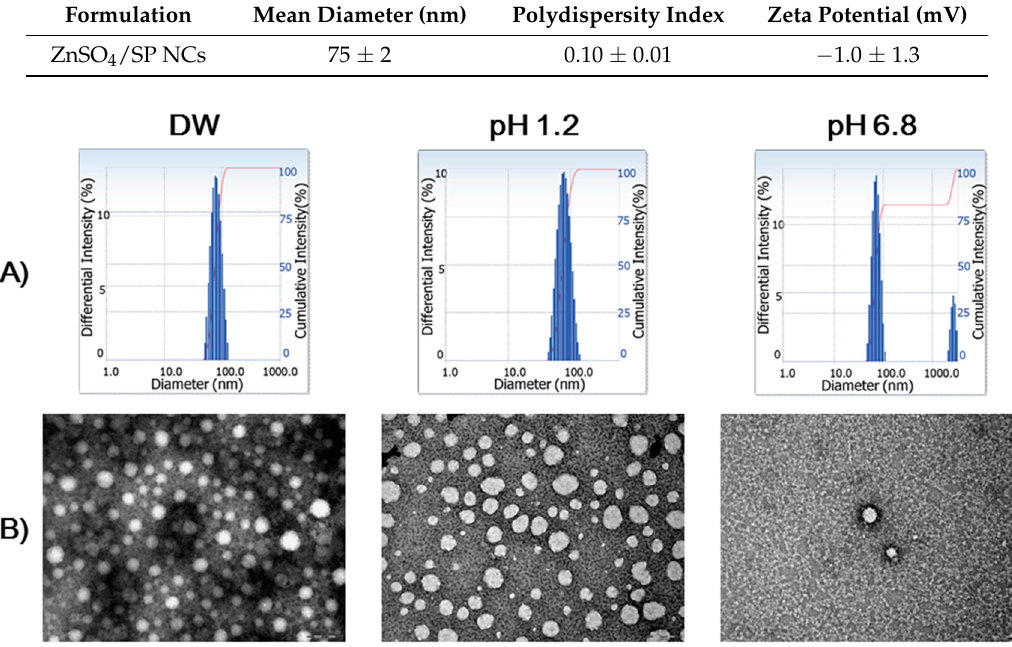
Figure 2. Particle characterization of ZnSO 4 /SP NCs dispersion. ( A ) Particle size distribution and ( B ) TEM images of ZnSO 4 /SP NCs in distilled water (DW), pH 1.2 medium, and pH 6.8 buffer are presented. The length of scale bar in the TEM image is 200 nm.